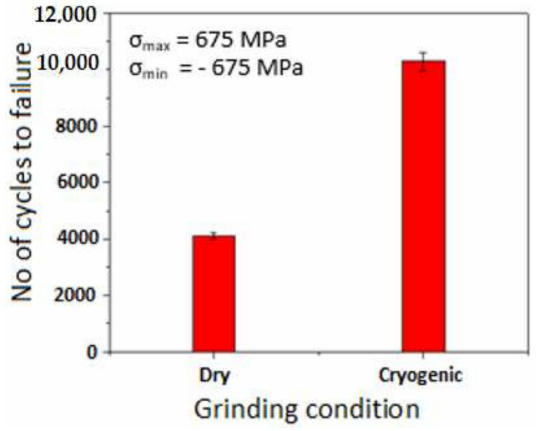
Figure 10. Fatigue test results for DMLS and aged maraging steel subjected to dry and cryo- genic